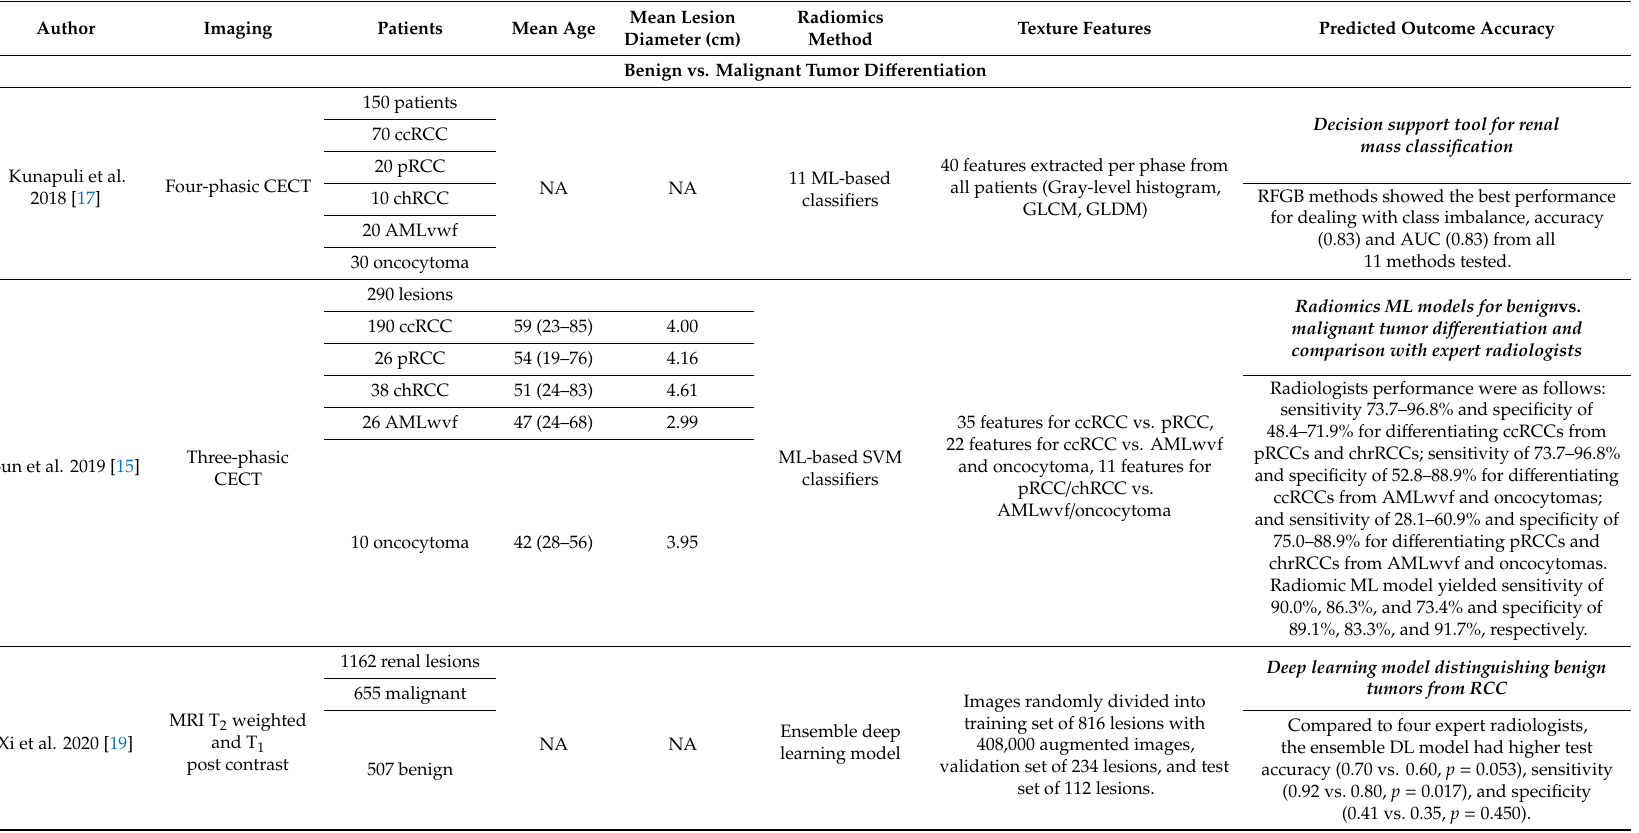
Table 1. Summary of studies applying radiomics for renal tumor di ff